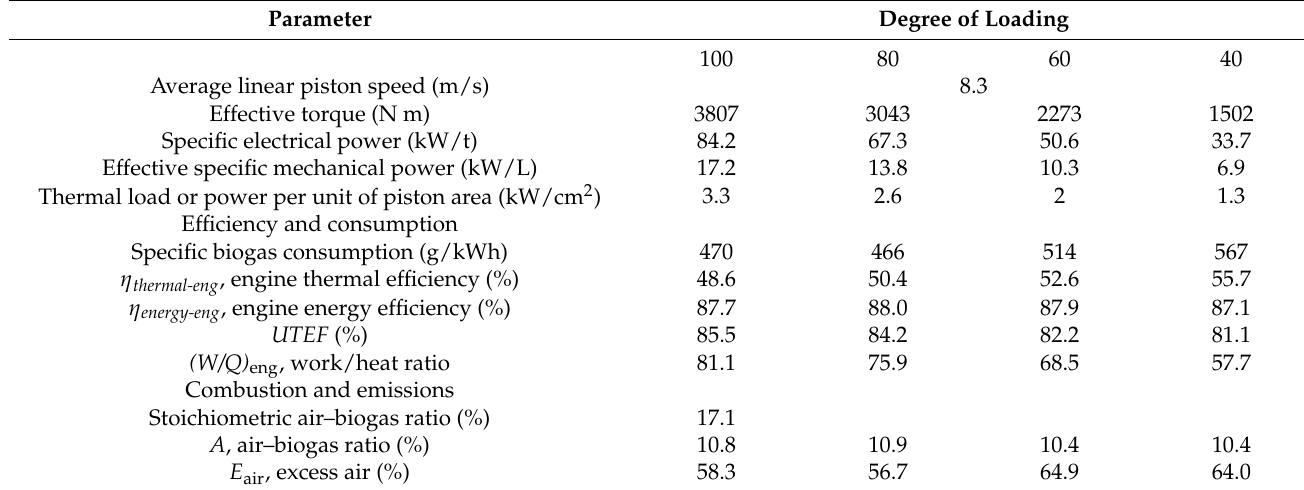
Table 6. Key parameters of biogas engines calculated at different degree of loading.